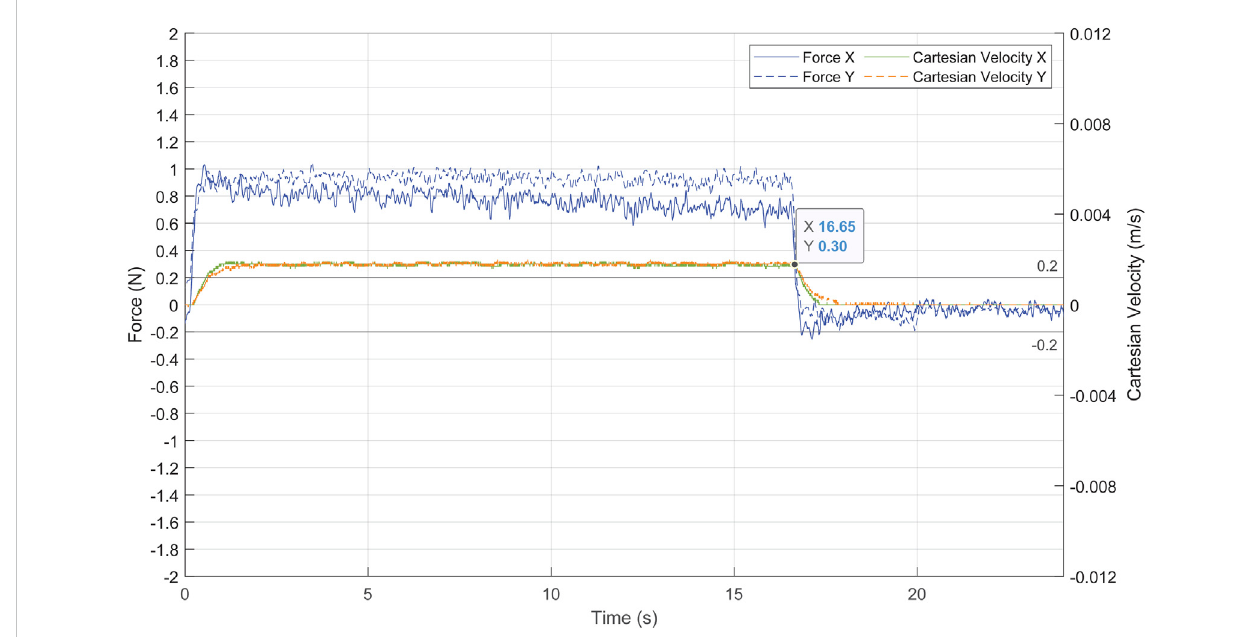
FIGURE 15 Forces exerted at the trocar in blue and Cartesian velocity of the TCP in green and